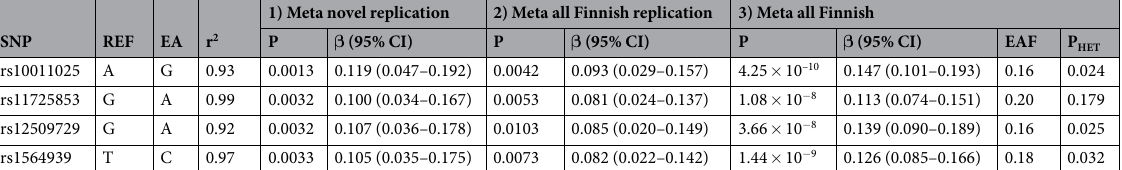
Table 2. Replication and meta-analysis results for the SNPs in the GLRA3 locus selected for replication in the original study. Results are given for (1) meta-analysis of the two novel replication cohorts (24-hour AER and nu-AER, N = 902 and 357, respectively); (2) meta-analysis of these and the previous replication (nu-AER, N = 598; ref. 7 ); and (3) meta-analysis of all Finnish cohorts, including the original GWAS finding (24-hour AER, N = 1925, ref. 7 ), previous replication study, and the two current replication sets. REF: Reference allele;